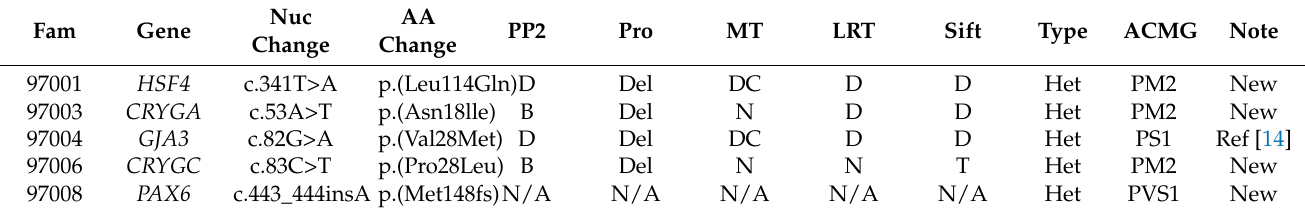
Table 2. Mutations Identified In Families With Congenital